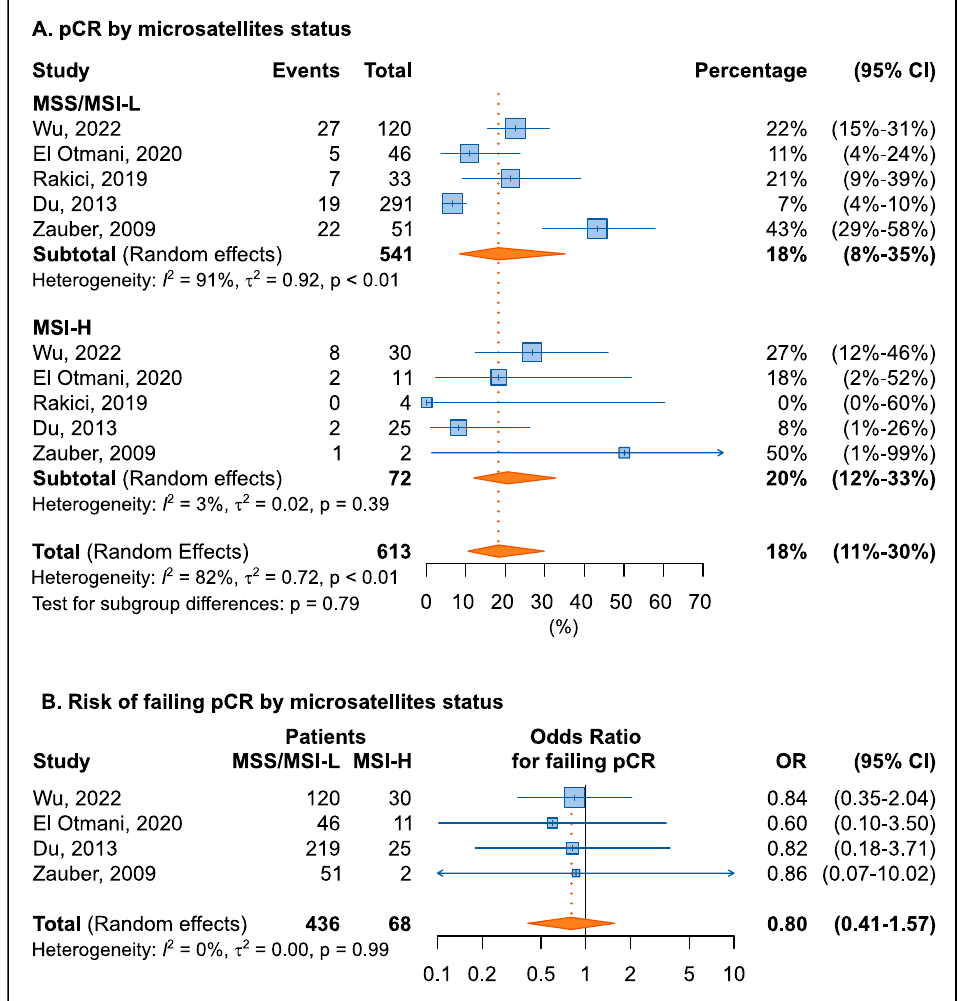
Figure 4. Forrest plot for percentage of pathological complete response (pCR, ( A )) and for the risk of not achieving a pCR ( B ) by microsatellite status. dMMR was considered as MSI-H, while pMMR or MSI-L are considered as microsatellite stable MSS.